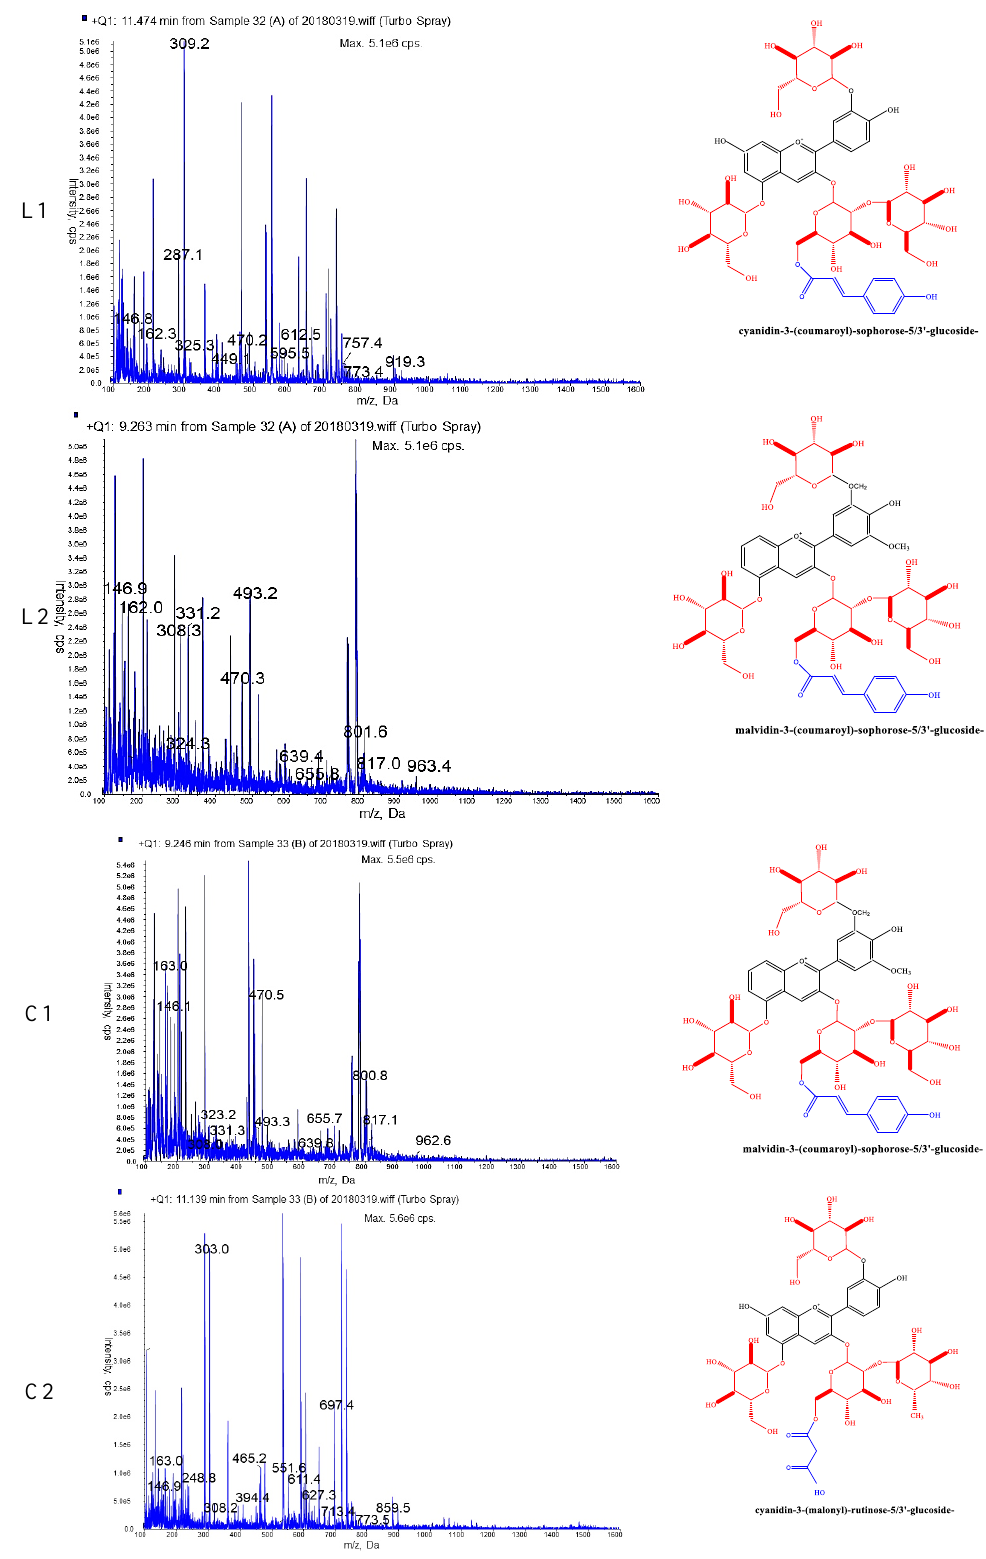
Figure 4. HPLC–MS chromatograms and corresponding structures of major anthocyanins of two varieties of Ranunculus asiaticus L. L1 and L2 were the major anthocyanins of variety ‘Jiaoyan zhuanhong’; C1 and C2 were the major anthocyanins of variety ‘Jiaoyan yanghong’. 2.3.3. Change Traits of Expression Levels of c72570 , c130622 , and c83020